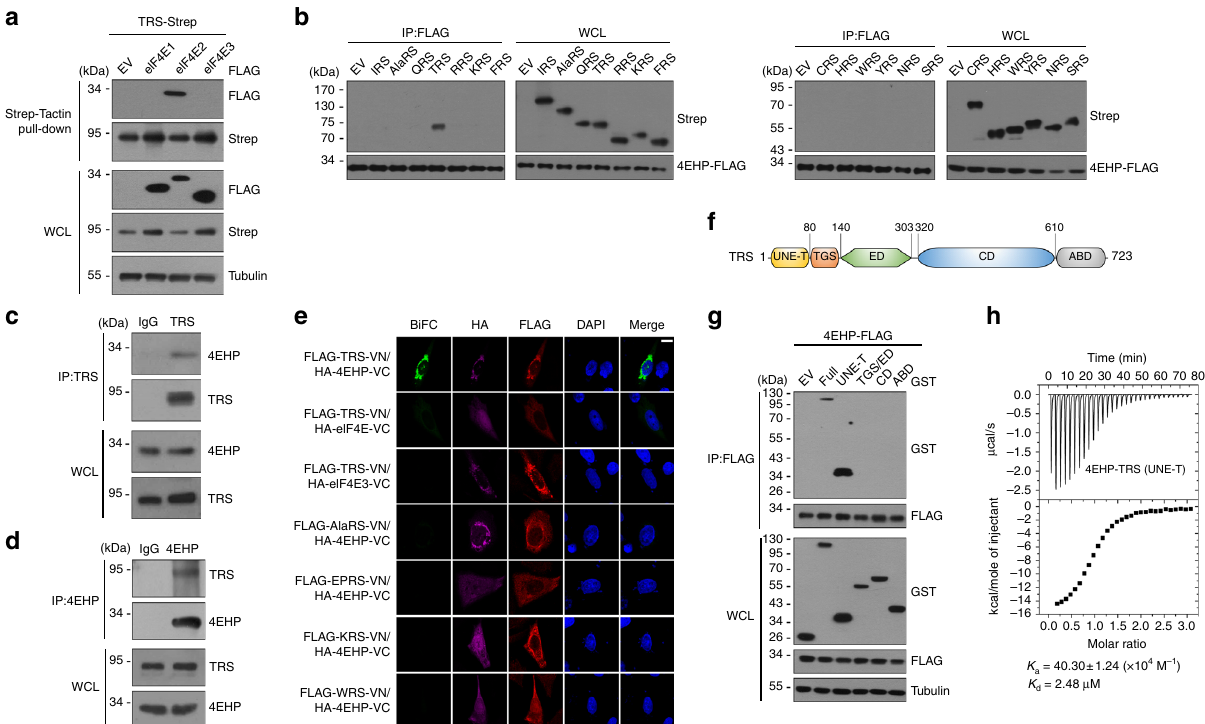
Fig. 1 Human TRS interacts speci fi cally with eIF4E2 (4EHP). a Pull-down assay of co-expressed TRS-Strep and eIF4E-FLAG isoforms in 293T cells. TRS- Strep was pulled down with Strep-Tactin beads, and co-precipitation of eIF4E isoforms was analyzed by immunoblotting with anti-FLAG antibody. b Immunoassay of co-expressed 4EHP-FLAG with human ARSs in 293 T cells. 4EHP-FLAG was immunoprecipitated with anti-FLAG antibody, and co- precipitation of ARSs-Strep was determined by immunoblotting with anti-Strep antibody. c Endogenous TRS immunoprecipitation with anti-TRS antibody in WI-26 cell lysates and co-immunoprecipitation of endogenous 4EHP determined using anti-4EHP antibody. Rabbit IgG was used as a negative control. d Co-immunoprecipitation of the above proteins con fi rmed in the reverse order. Rabbit IgG was used as a negative control. e Interactions between the indicated protein pairs determined by reconstitution of Venus green fl uorescent protein (GFP) in Chinese hamster ovary (CHO) cells. Nuclei were stained with 4 ′ ,6-diamidino-2-phenylindole (DAPI; blue). Expression of HA-4EHP and FLAG-TRS was con fi rmed by immuno fl uorescence staining with anti-HA (Alexa 647; purple) and anti-FLAG (Alexa 594; red) antibodies, respectively. Scale bar = 10 μ M. f Domain structure of human TRS determined based on the crystal and solution structures of E. coli (PDB 1QF6) and human (PDB 1WWT) TRS. g Immunoassay of co-expressed 4EHP-FLAG with full-length GST- TRS or the indicated domains in 293 T cells. Cell lysates were immunoprecipitated with anti-FLAG antibody, and co-precipitated TRS domain(s) were determined by immunoblotting with anti-GST antibody. h ITC determination of the binding af fi nity and stoichiometry of the TRS UNE-T region and 4EHP. Raw data and the integration plot are displayed in the upper and lower panel, respectively. Data are representative of at least three experiments, each with similar results ( a − e , g , h ). EV empty vector, WCL whole cell lysate, VN venus N-domain, VC venus C-domain, UNE-T unique region extension at the N- terminus of TRS, TGS a domain named after TRS, GTPase and SpoT, ED editing domain, CD catalytic domain, ABD anticodon-binding